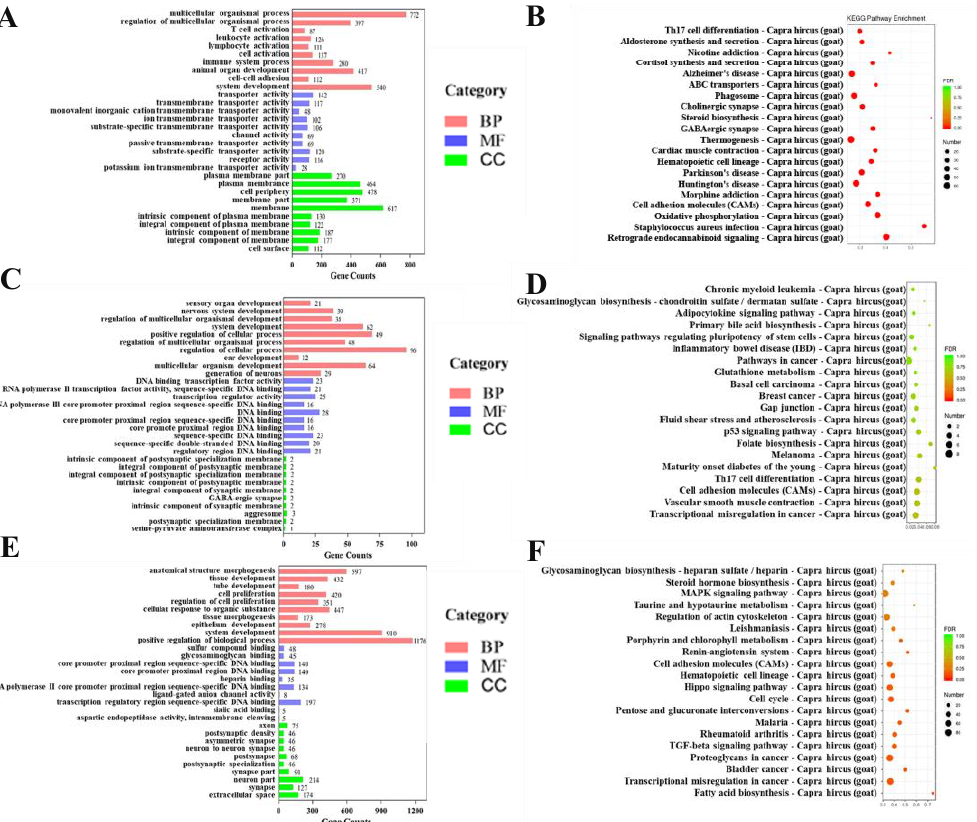
Figure 2. GO and KEGG enrichment analysis of DEmRNAs and target genes of DElncRNAs and DEmiRNAs. GO analysis of DEmRNAs ( A ) and predicted target genes of DElncRNAs ( C ) and DEmiRNAs ( E ). The top 20 KEGG pathways of predicted target genes for DEmRNAs ( B ) and DElncRNAs ( D ), and DEmiRNAs ( F ). “Count” means the number of predicted target genes enriched in this pathway. The color represents the degree of enrichment, with red representing significant enrichment. Red represents the biological process (BP), blue represents the molecular function (MF), and green represents the cell component (CC).